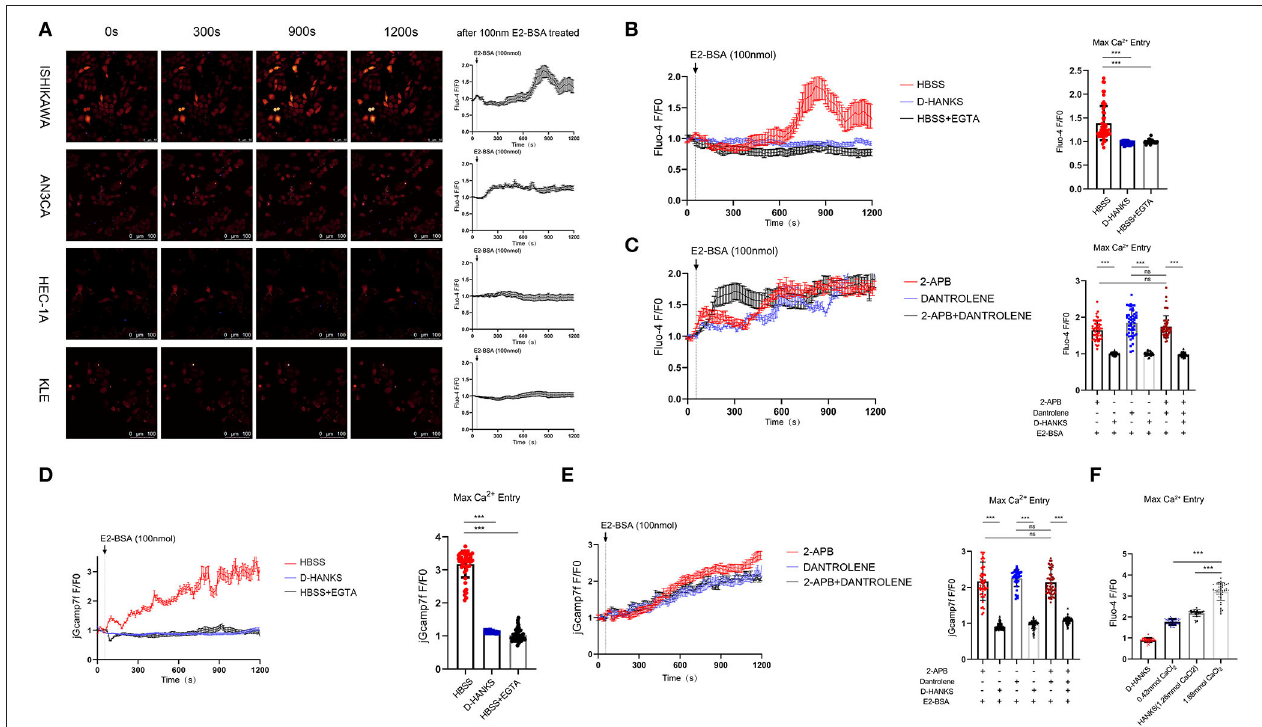
FIGURE 2 | The calcium homeostasis regulated by estrogen in EC cells is derived from extracellular calcium influx but not the release of the endoplasmic reticulum. (A) The effect of E2-BSA of EC cell lines on calcium influx. Depicted are representative confocal images after adding 100nm E2-BSA on the 60s. Average fluorescence intensity of each cell in the field (F), normalized to the non-specific background fluorescence (F0) to obtain the fluorescence intensity (F/F0). (B) E2-BSA stimulation of Ishikawa cells with calcium-free buffer solution D-HANKs or calcium chelating agent EGTA to remove extracellular calcium levels. N = 50. (C) E2-BSA stimulation of Ishikawa cells with inhibitors of endoplasmic reticulum calcium release (2-APB and Dantrolene 10 µ m) for 30min. (D,E) GECI probe jGcamp7f transfected Ishikawa cells with E2-BSA stimulated calcium imaging. (F) Effect of different concentrations of calcium levels on estrogen-regulated calcium influx. All data are presented as the means ± SE. n = 50 for cell numbers and n = 3 for replicated. ns, non significant; *** p < 0.001. compared with the control